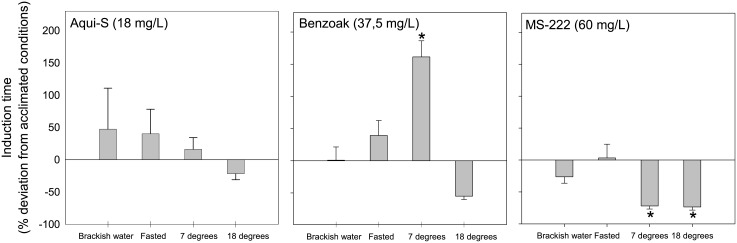
Induction under altered conditions.Deviation in induction time of lumpfish fries (Cyclopterus lumpus) to surgical anaesthesia (stage 3b) by SB concentrations of Aqui-S, Benzoak, and MS-222 when fries were exposed to these agents in brackish water (15 ppt–18 ppt), when fasted for three days, or at temperature lowered by 5 °C to 7°C or increased by 6°C to 18°C. Values are mean ± SD. N = 10. Asterisks indicate statistical differences from acclimated condition.